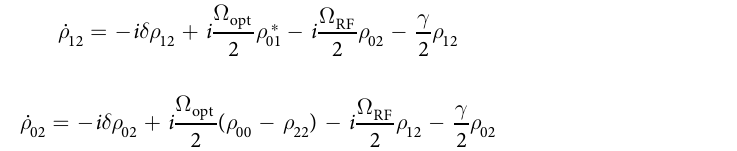
Figure 2. Solving the optical Bloch eqs (1–6) with Rabi flopping at Ω RF = 2 π × 10.3 kHz and an initial state |0 〉 . Unobserved dynamics with Ω opt = 0 (grey, thick). At 20 μ s (blue, solid) and 30 μ s (red, solid) the observing optical transition is added with “collapse” description this freezes the dynamics which is seen to be a good approximation. It is an even better one for larger γ and Ω opt . The dotted lines are computed for ten times larger Ω opt and γ . Note that the coherences (not shown) are set to zero by the strong optical transition, such that the system is found in either its states with a probably given by the diagonal elements of ρ , in accordance with the QZE. The parameters used in this plot do not agree well with the intended application but are instead chosen to match with the rudimentary experimental demonstration presented